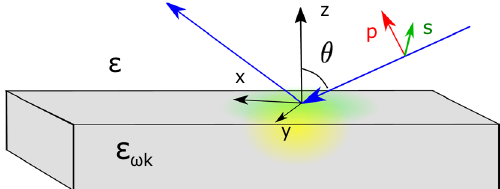
Figure 1. Illustration of the problem geometry. A wave approaching at the incident angle θ is reflected from 0 . TM ( p ) and TE ( s ) polarizations differ by the orientation of the electric field a surface of a metal at z = with respect to the surface, the field penetrating the sample is schematically illustrated by green and yellow, representing ASE and SASE